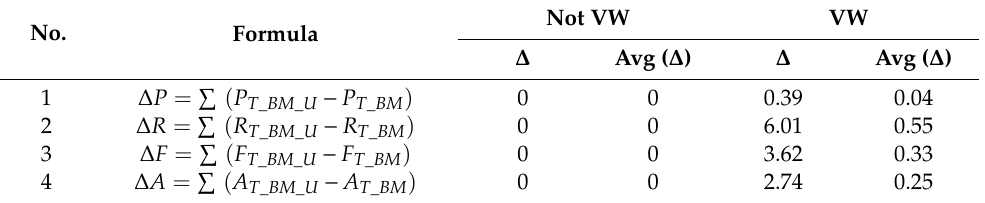
Table 7. Comparison of Boyer–Moore (BM) and Boyer–Moore-U (BM-U) retrieval of T.